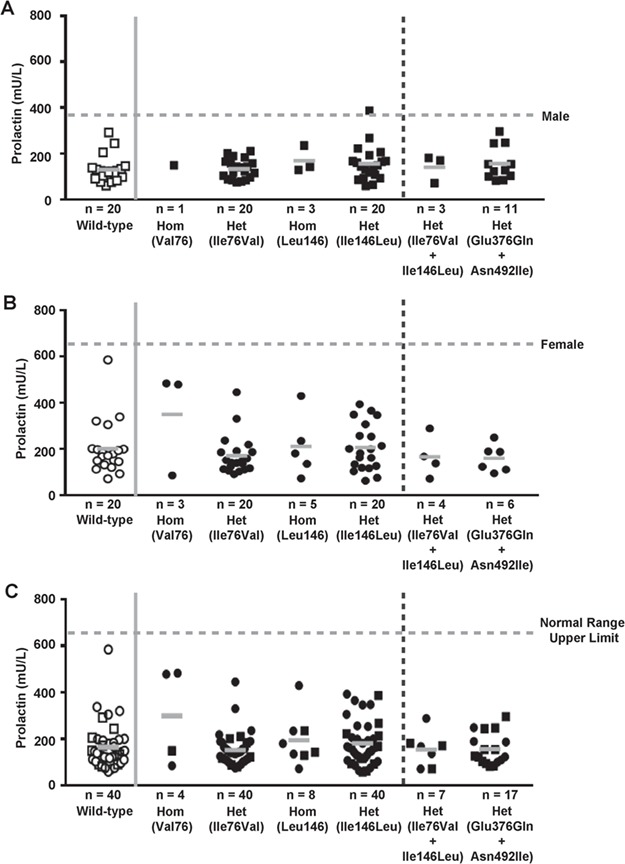
Serum prolactin concentrations of individuals from the OBB data set with PRLR variants. (A) Males (filled squares). (B) Females (filled circles). (C) Combined males and females. Males and females, with four of the six PRLR variants from the OBB cohort (Table 1), are grouped by homozygous (hom) and heterozygous (het) genotypes. Individuals having only the WT alleles (i.e. haplotype Ile76/Ile146/Glu376/Asn492) were used as controls (open squares, male; open circles, female) and are shown left of the vertical solid gray line. Prolactin was measured in samples available from 40 (20 males and 20 females) of the >6600 individuals homozygous for the WT alleles; 4 of the 7 individuals homozygous for Val76, and 40 (20 males and 20 females) of the 404 individuals heterozygous for Ile76Val; 8 of the 10 individuals homozygous for the Ile146, and 40 (20 males and 20 females) of the 402 individuals heterozygous for Ile146Leu; 7 of the 8 individuals with the Ile76Val/ Ile146Leu haplotype; and 17 of the 28 individuals with the Glu376Gln/ Asn492Ile haplotype (Table 1). In addition, only one patient had the Gly57Ser PRLR variant, and this was not included in the study. Individual measurements are shown with mean values indicated by a solid gray bar. Prolactin concentrations in individuals with more than one PRLR variant are shown right of the vertical broken line. Upper limit of the prolactin normal ranges for males (45–375 mU/L) and females (60–625 mU/L) is shown by the horizontal broken gray line. For panel C, the upper limit of the prolactin normal range for females is shown. Individuals heterozygous or homozygous for the minor allele of Ile76Val and Ile146Leu, which each had a prevalence of <5% in the OBB cohort, and individuals heterozygous for the co-occurring Glu376Gln and Asn492Ile variants, did not have hyperprolactinaemia.